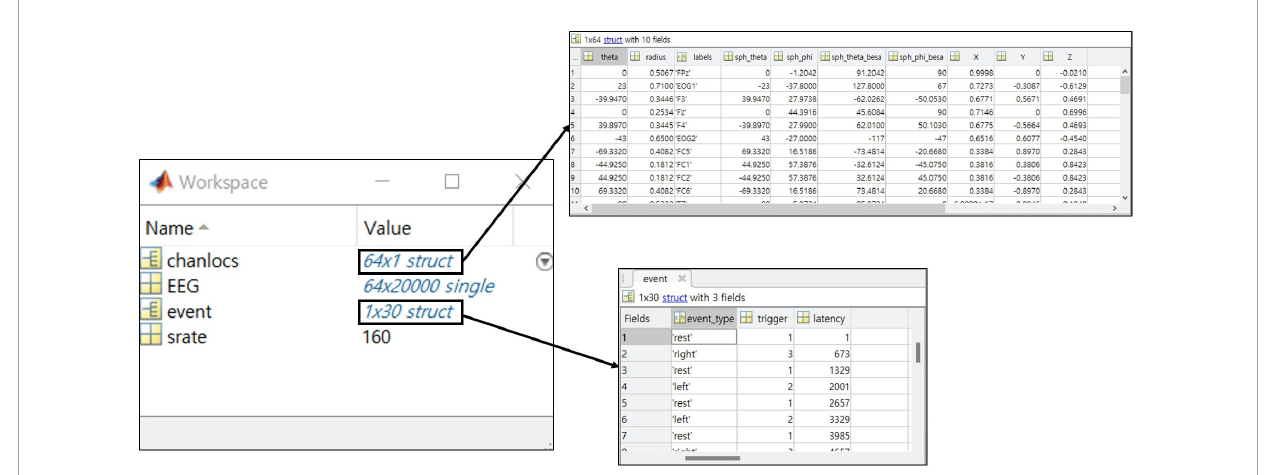
FIGURE6 The example of a structure for the recommended dataset with a MATLAB data structure preview.